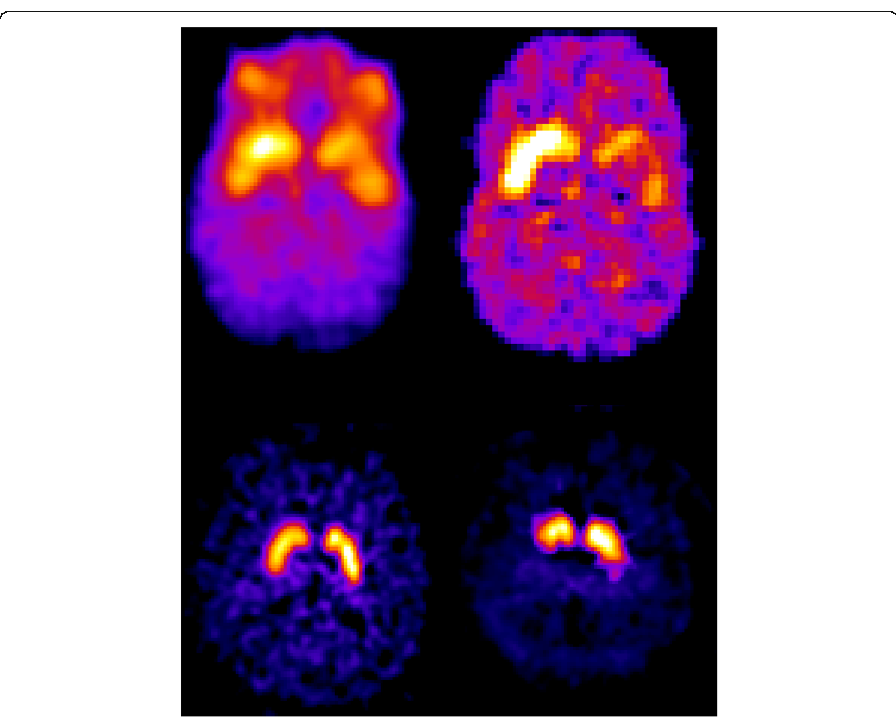
Fig. 6 Top: striatal phantom DAT images with a right striatal-to-background ratio of 4.6:1 and a left striatal- to-background of 3.5:1. Left image shows the clinical reconstruction, and right the research reconstruction. Below: a typical example of a [ 123 I]ioflupane SPECT scan acquired 4 h post-injection from a healthy subject (left) and a patient with striatal dopaminergic deficit due to Parkinson ’ s disease (right). Subjects were injected with ~ 111 MBq [ 123 I]ioflupane. Only the clinical reconstruction is